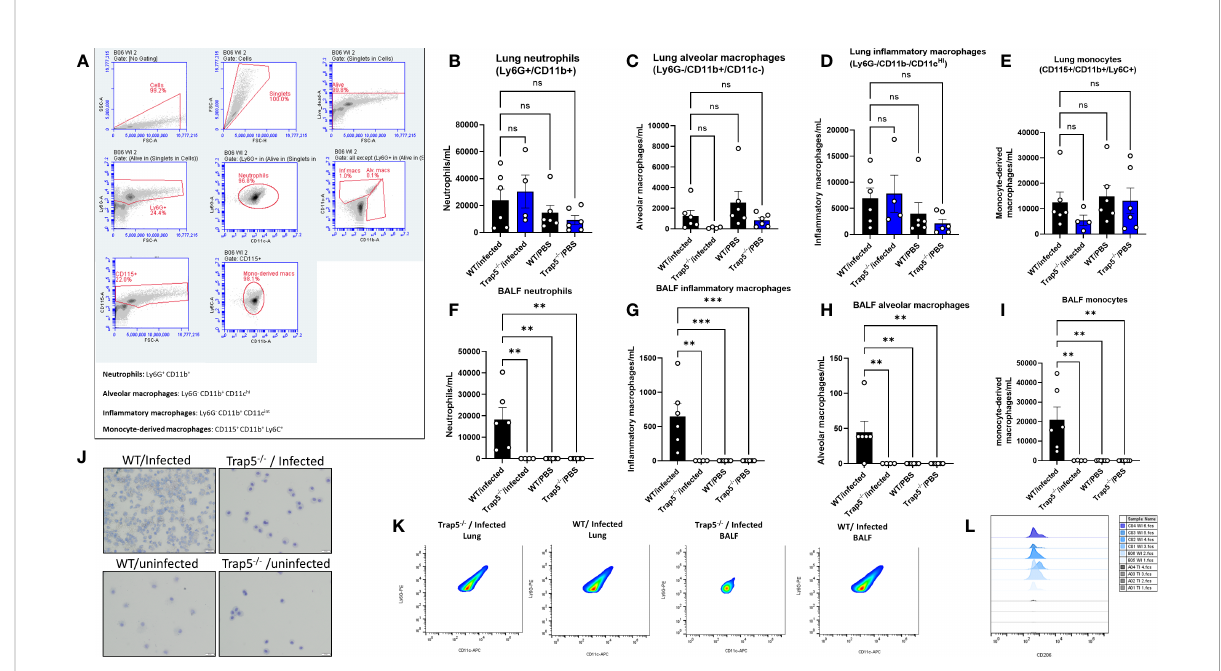
FIGURE 3 Immune cell recruitment following bacterial infection. (A) Representative gating of murine cells is shown from Trap5 -/- and WT infection experiments. (B – E) Murine lung cells and (F – I) BALF cells were quanti fi ed per mL of tissue or fl uid. Murine neutrophils (live dead + /Ly6G + / CD11b + ), alveolar macrophages (live dead + /Ly6G - /CD11b + /CD11c - ), in fl ammatory macrophages (live dead + /Ly6G - /CD11b + /CD11c intermed),